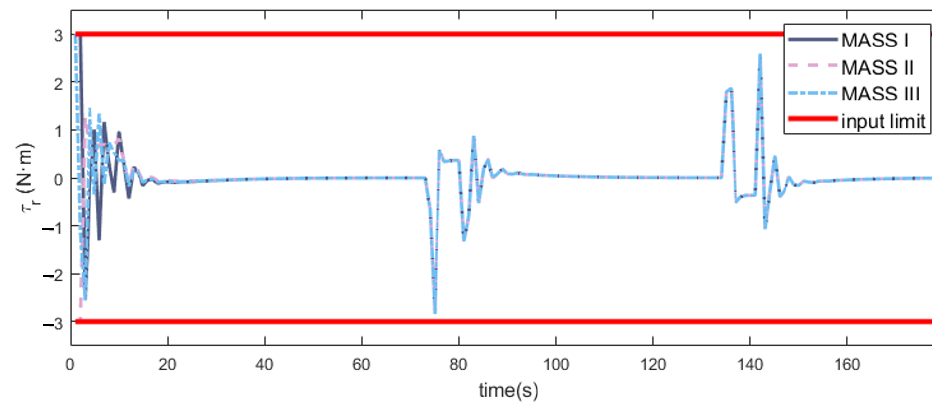
Figure 10. Heading torque of MASSs.